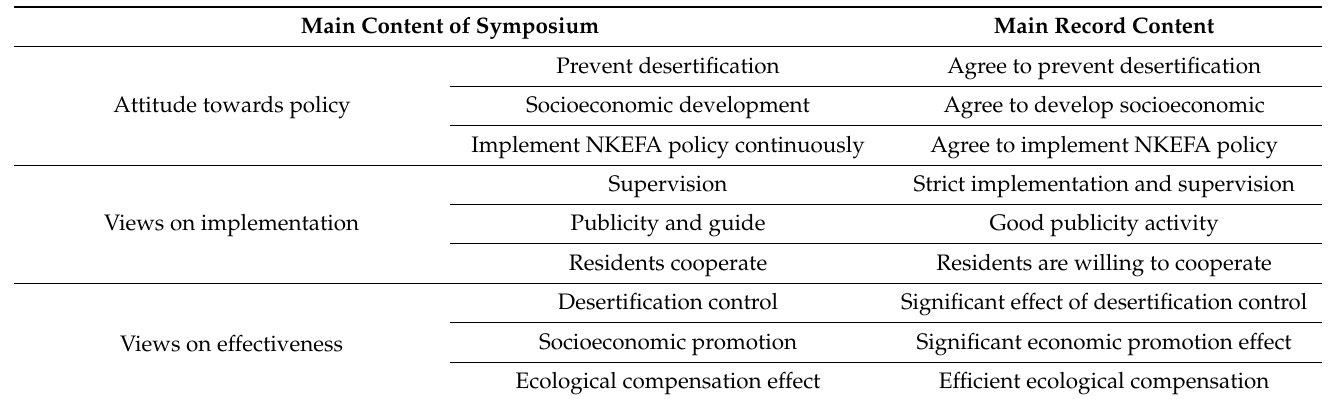
Table 4. The main content of the symposium record.